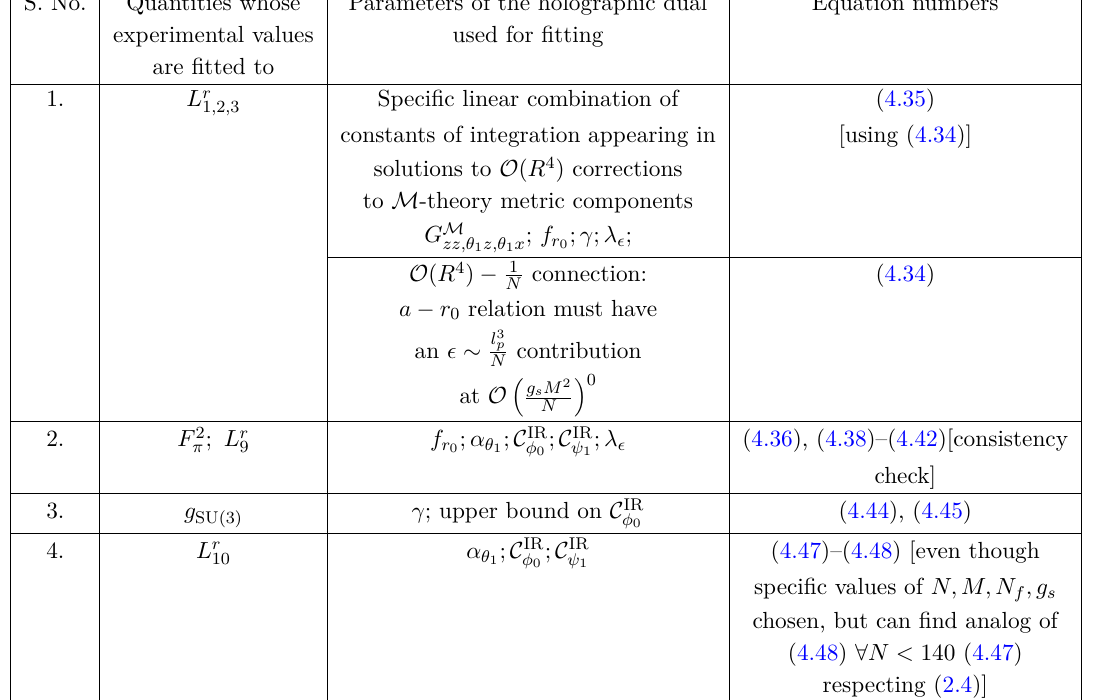
Table 5 . Summary of Matching of Parameters of the M -theory uplift and Experimental values of 1-Loop renormalized χ PT LECs, F 2